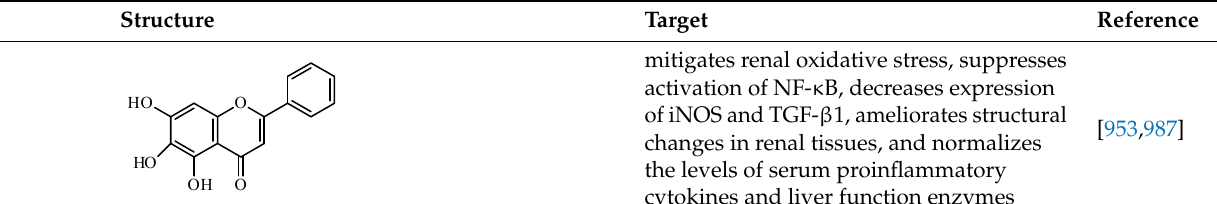
Table 4. Sources, structure, and target of some potential antidiabetic phytochemicals.